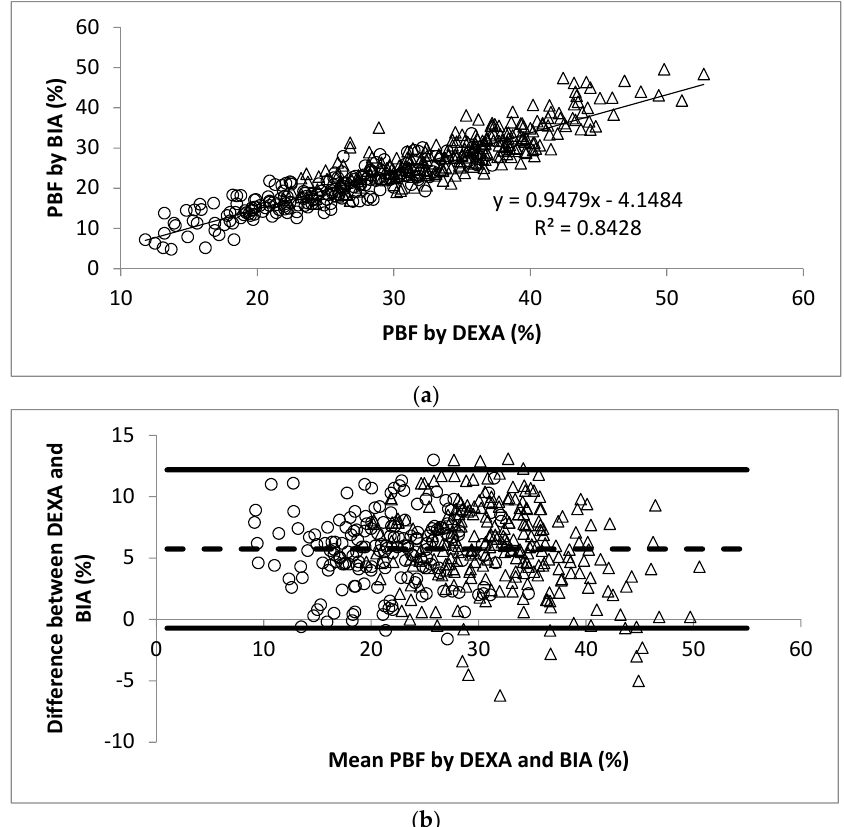
Figure 2. ( a ) Scatter plot of PBF calculated by DEXA and BIA in 445 participants. The Pearson’s correlation coefficient is 0.92; ( b ) Bland-Altman plot for data from ( a ). Men were represented by the open circles and women by the open triangles.